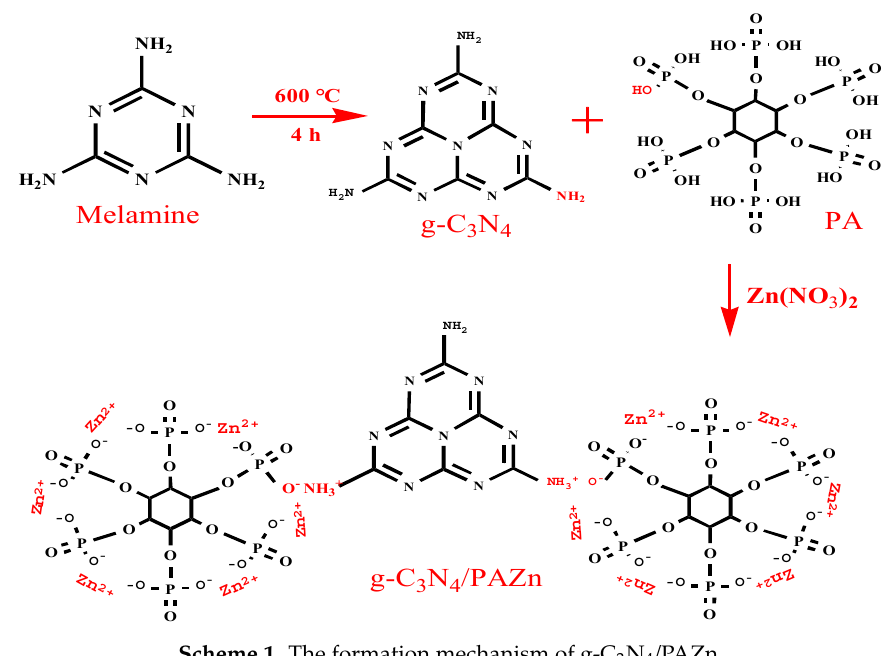
Scheme 1. The formation mechanism of g-C 3 N 4 / PAZn. Table 1. The composition of epoxy resin (EP) Table 1. The composition of epoxy resin (EP) composites.